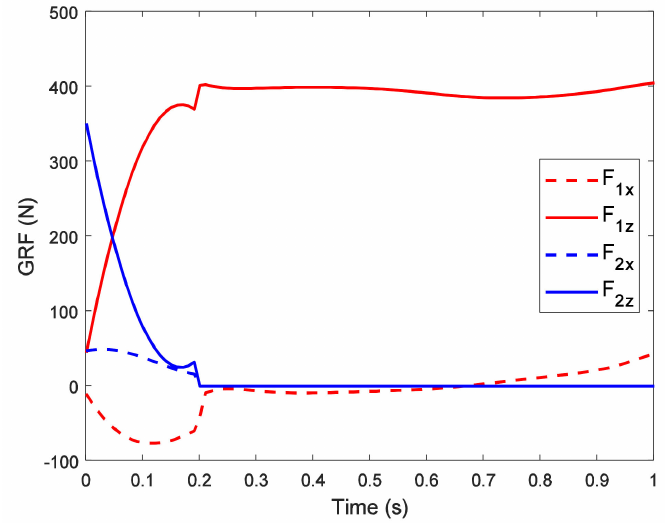
Figure 7. Trajectories of ground reaction force